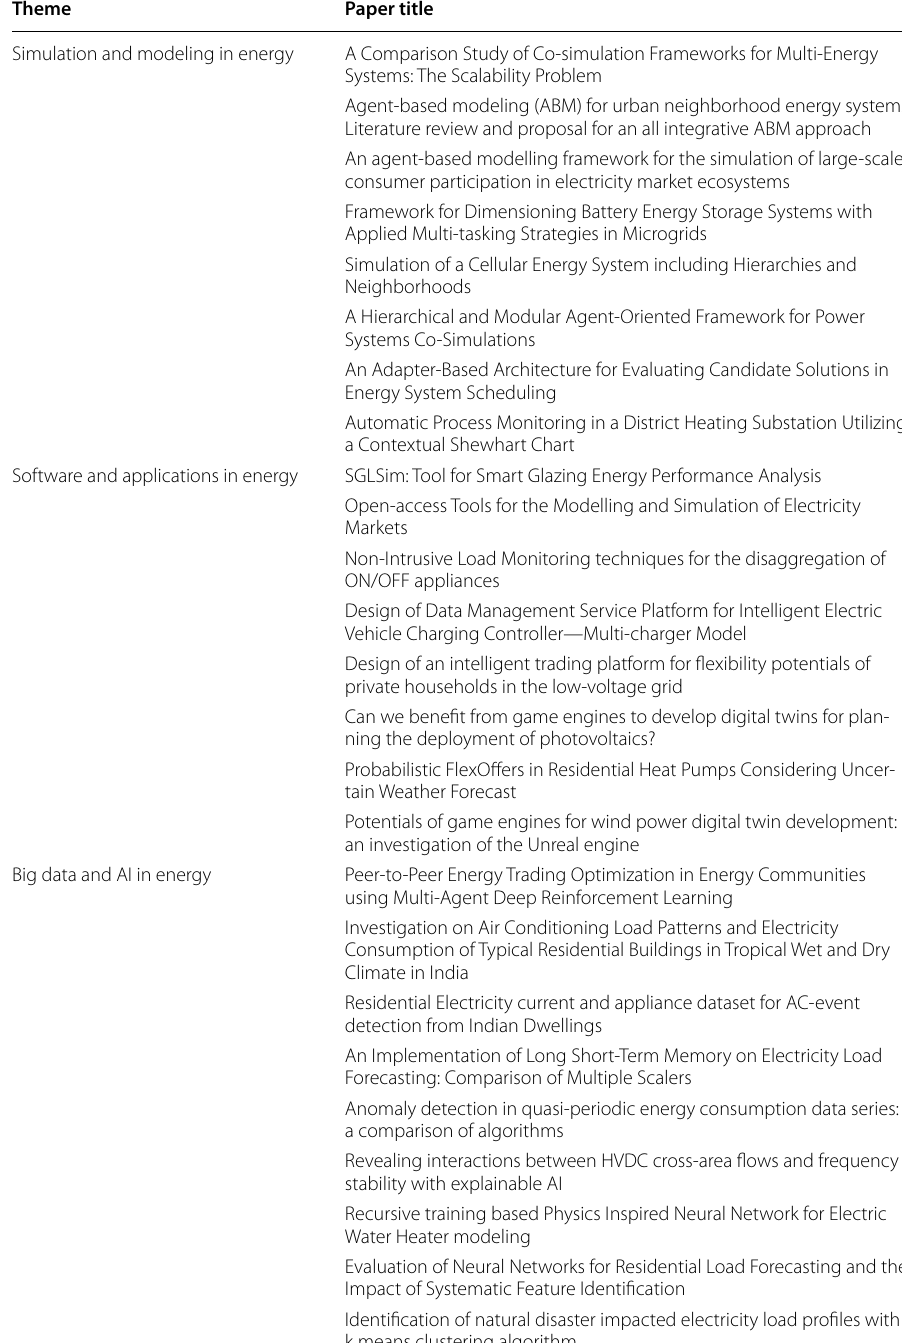
Table 1 Themes of the accepted and presented papers from Energy Informatics.Academy Conference 2022 (EI.A